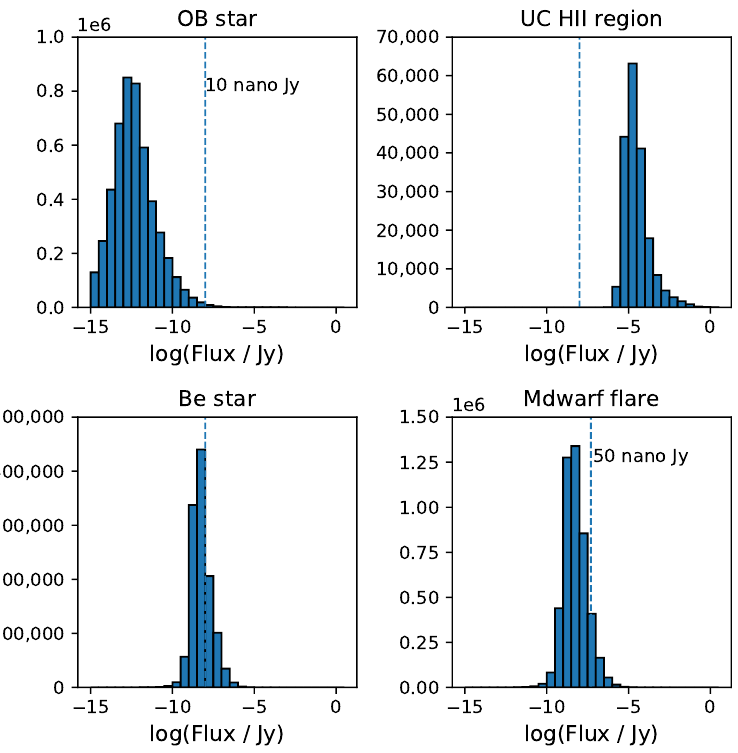
Figure 4. The distribution of estimated flux of all our samples. The blue dashed line represents the assumed detection limit of the SKA.